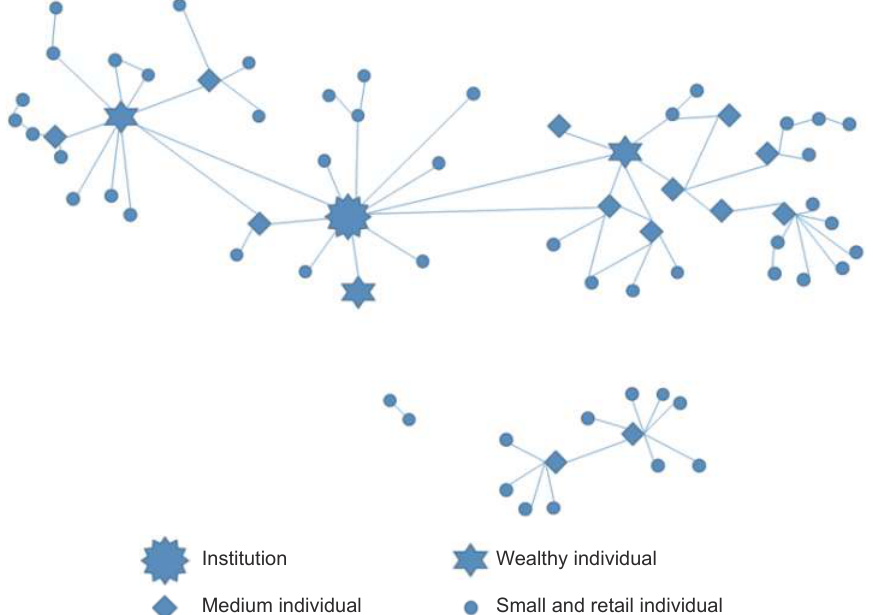
Fig. 2 A representative of investors’ social